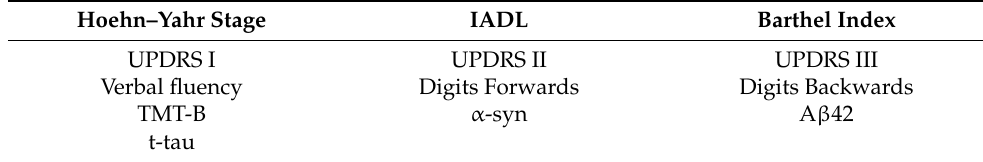
Figure 2. ROC curve and AUC results for each 32-parameter classifier of CDR-SB deterioration. Table 4. Condensed thirteen parameters as the model predictors.